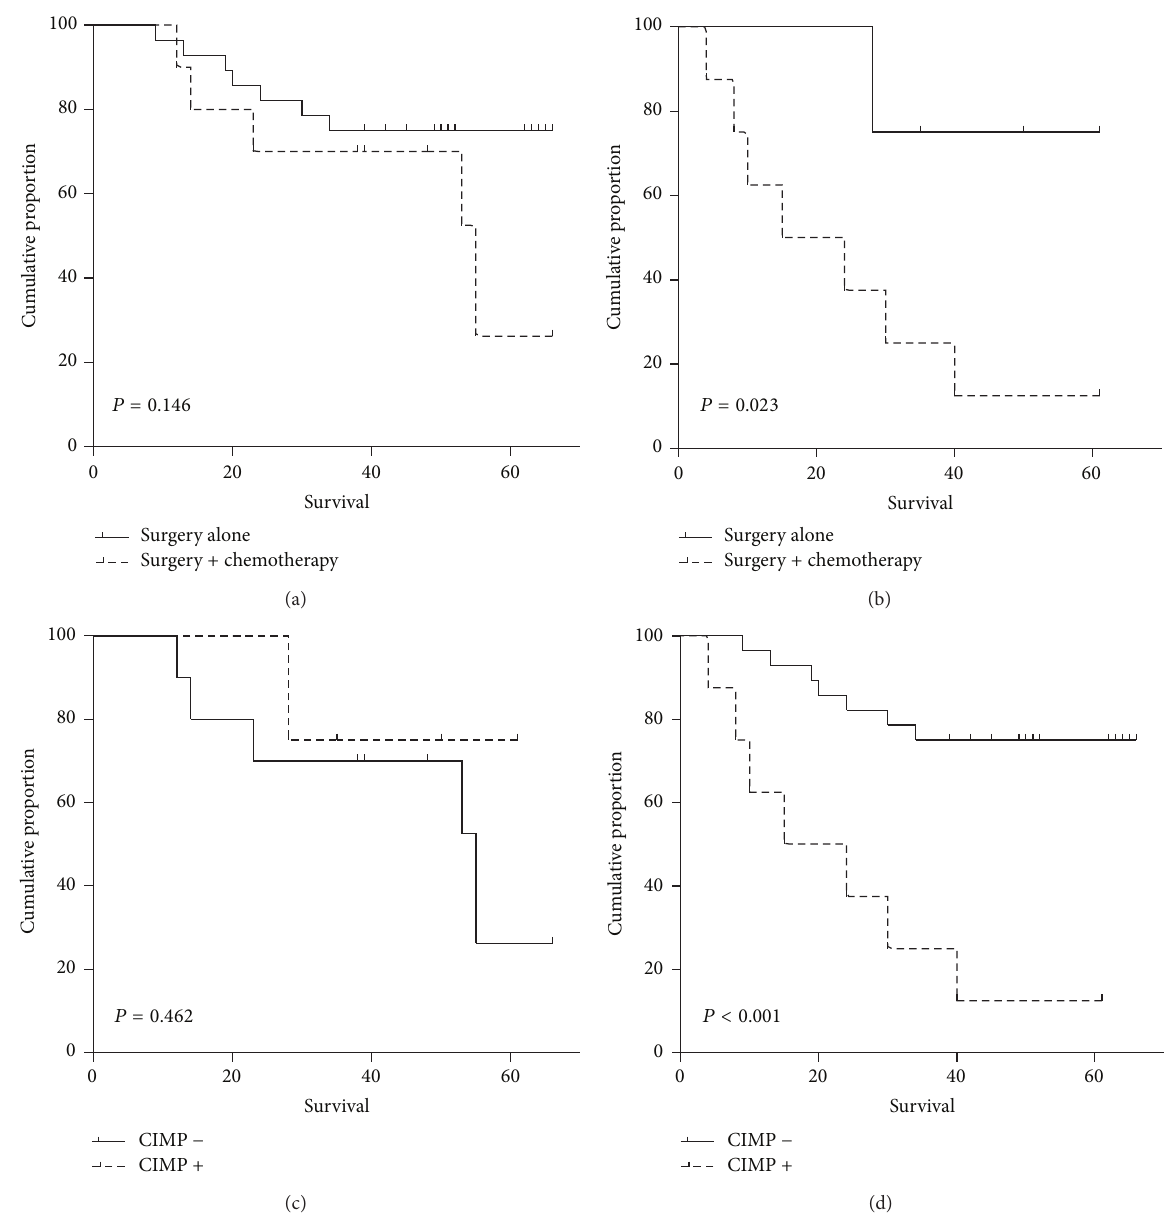
Figure 2: Disease-free survival analysis stratified by CIMP status and treatment jointly. In CIMP negative tumors, adjuvant chemotherapy showed no effect on DFS with 𝑃 value =0.146 (a). Chemotherapy decreased DFS in CIMP+ tumors significantly with 𝑃 value =0.023 (b). CIMP status showed no effect on DFS in patients treated with surgery alone with 𝑃 value =0.462 (c). In patients receiving surgery plus adjuvant chemotherapy, CIMP positive patients had a significantly poor DFS than those negative with 𝑃 value < 0.001 (d). DFS: disease-free survival, CIMP: CpG island methylator